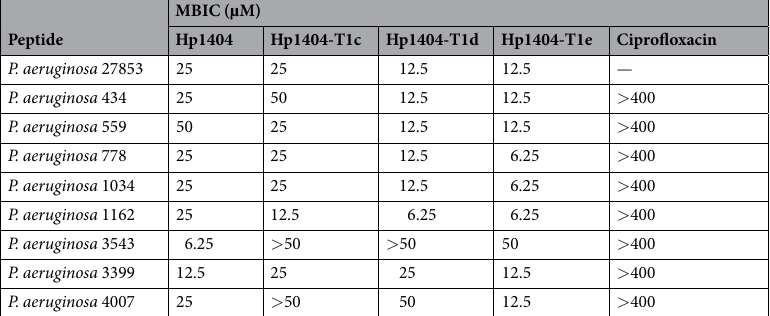
Table 4. MBIC values of the parent Hp1404 peptide and three of its analogues, as well as ciprofloxacin, against P. aeruginosa